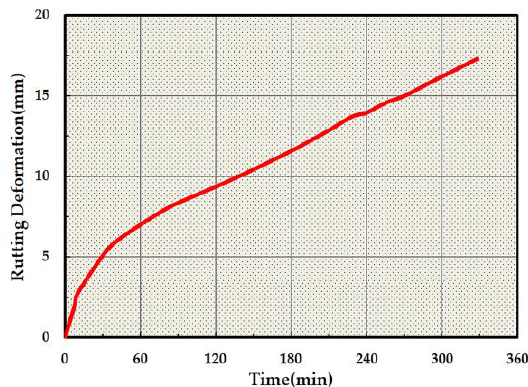
Materials 2020 , 13 , x FOR PEER REVIEW Figure 10. Deformation curve of the virtual track test. Figure 10. Deformation curve of the virtual track test.